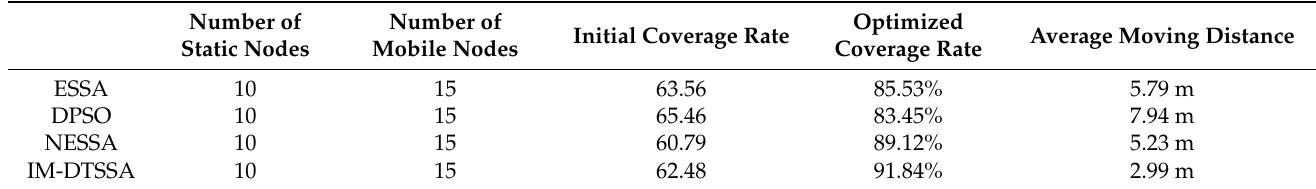
Table 3. Comparison of WSN performance in the area of 20 m × 20 m.